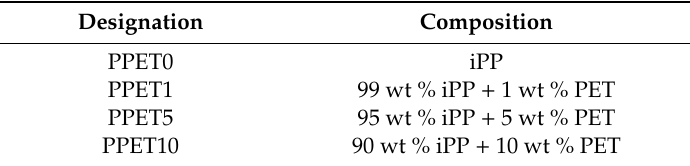
Figure 1. Schematic of samples for measurements. FD: flow direction, TD: transverse direction, ND: normal direction. SAXS: Small-Angle X-ray Scattering; DSC: differential scanning calorimetry; WAXD: Wide-Angle X-ray Diffraction; SEM: scanning electron microscopy; PLM: Polarized Light Microscope. Table 1. Material designation and composition of isotactic polypropylene / poly(ethylene terephthalate) (iPP / PET) and the blends.